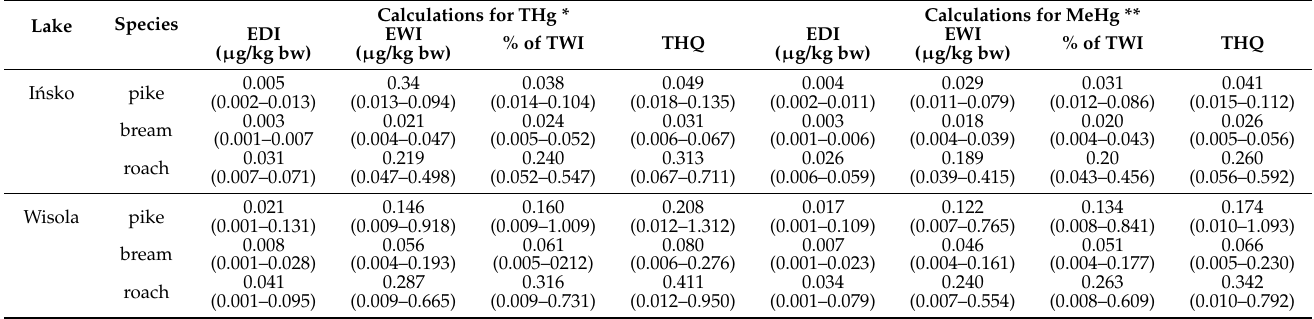
Table 8. Potential human health risk assessment for adults (mean,